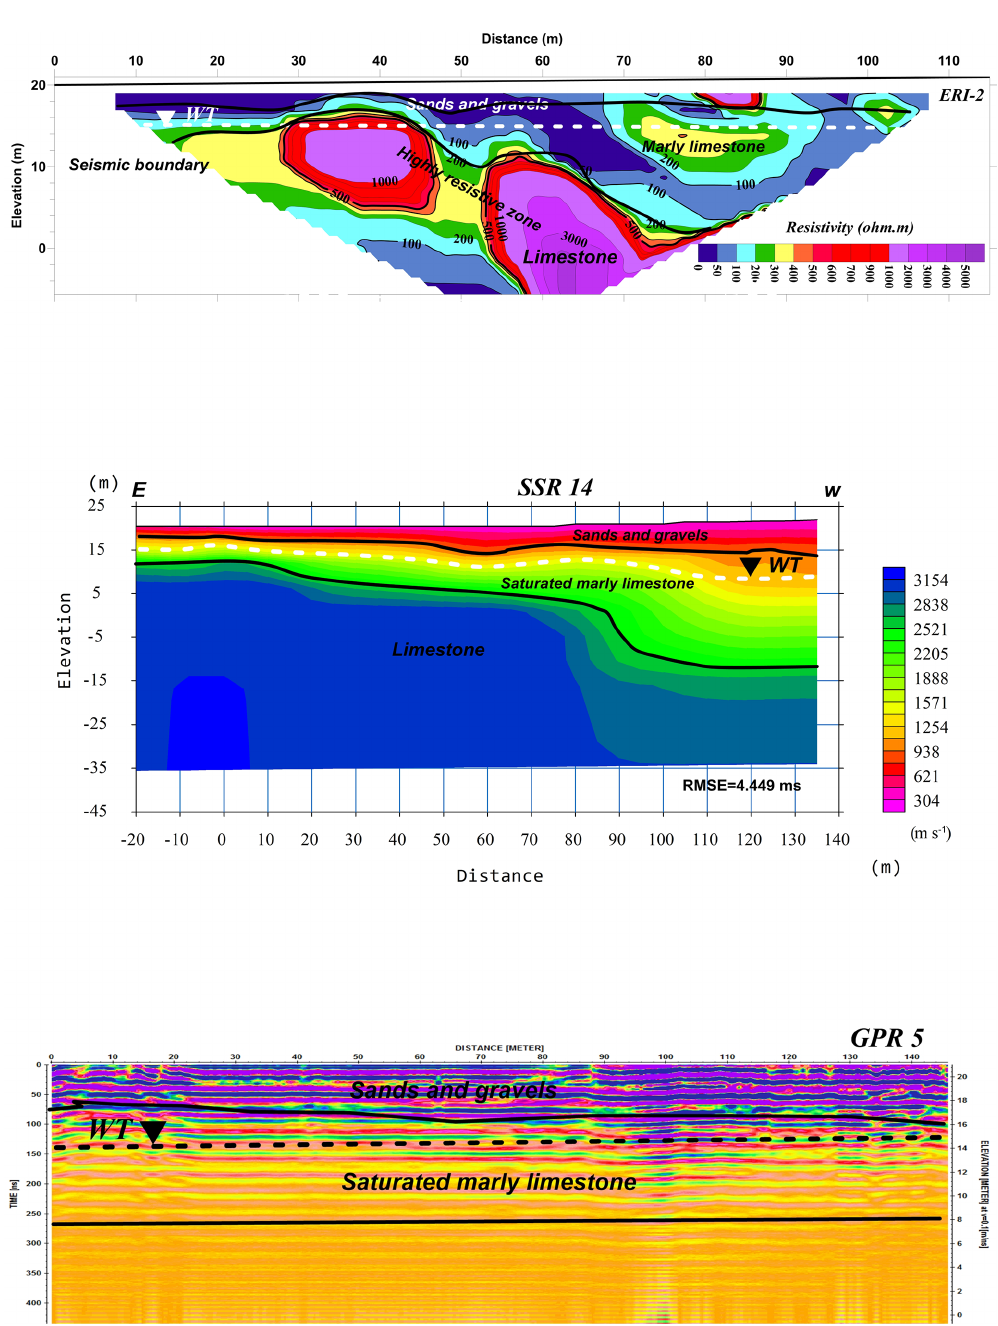
Figure 7. ERI, SSR, and GPR profiles in the Valley Temple of Khafre and central field of Mastaba.